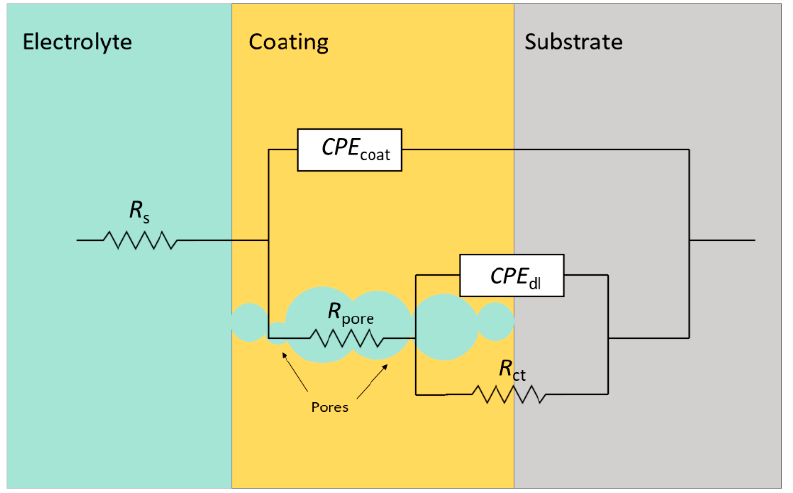
Figure 8. The electrical equivalent circuit (EEC) used to model the EIS data for the MC coating and the control coating.